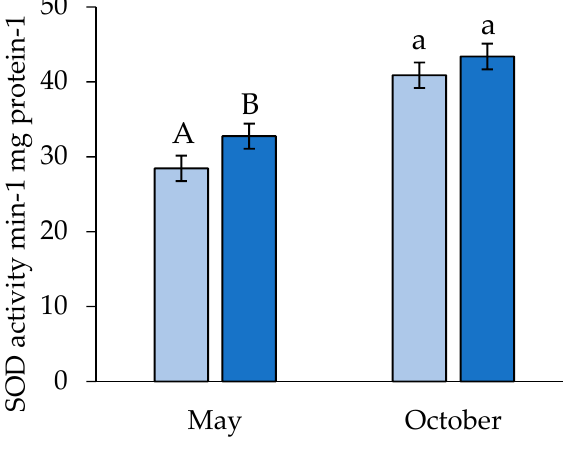
Figure 3. Activity of superoxide dismutase in 4th/5th instar honey bee larvae (mean ± SE). Letters indicate significant differences between feeding treatments within a replicate.